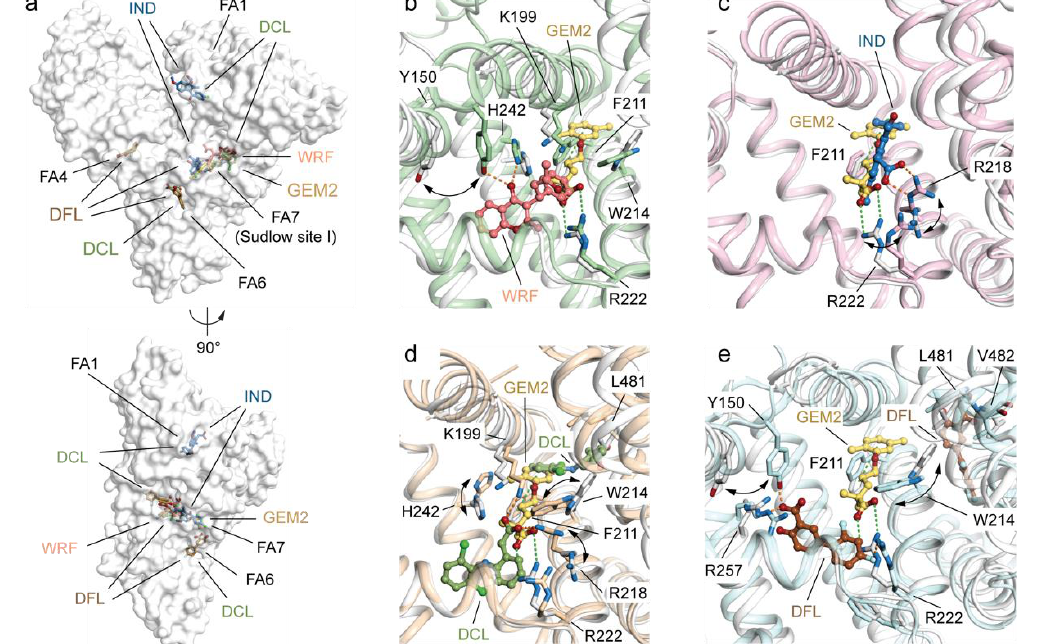
Figure 5. Structural comparison of the ligand binding mode of GEM2 with that of other known drugs binding HSA Sudlow’s site I (FA7) in sub-domain IIA. ( a ) Molecular surface representation of the overall HSA-GEM complex (white; PDB identification code: 7QFE) aligned with HSA-warfarin (WRF; PDB identification code: 2BXD), HSA-indomethacin (IND; PDB identification code: 2BXM), HSA-diclofenac (DCL; PDB identification code: 4Z69), and HSA-diflunisal (DFL; PDB identification code: 2BXE) complexes. The superimposed complexes are shown in two orientations (90 ◦ rotation). Detailed view of the superimposed GEM2 (yellow orange) to ( b ) WRF (salmon), ( c ) IND (sky blue), ( d ) DCL (smudge), ( e ) DFL (brown) molecules bound to Sudlow’s site II (FA4). The α -helices of HSA in complex with GEM2, WRF, IND, DCL, and DFL are represented by cartoon loops and coloured in white, pale green, light pink, wheat, and pale cyan, respectively. The selected labelled amino acid side chains are represented as sticks and coloured by atom type (carbon = white for the HSA-GEM2 complex, pale green for the HSA-WRF complex, light pink for the HSA-IND complex, wheat for the HSA-DCL complex, pale cyan for the HSA-DFL complex, firebrick for oxygen, and sky blue for nitrogen). Bound ligands are shown in a ball-and-stick representation and coloured by atom type (GEM2: carbon = yellow orange and oxygen = firebrick; WRF: carbon = salmon and oxygen = firebrick; IND: carbon = sky blue, oxygen = firebrick, and nitrogen = sky blue; DCL: carbon = smudge, oxygen = firebrick, nitrogen = sky blue, and chlorine = light green; and DFL: carbon = brown, oxygen = firebrick, and fluorine = pale cyan). For visualisation, only the side chains of amino acids of HSA forming inter-molecular polar interactions below 4.0 Å or presenting a notable difference are shown. Inter-molecular interactions are represented as dashed lines. Those established by GEM2 are coloured in light green while those formed by WRF, IND, DCL, and DFL are coloured in orange. The three-dimensional structure models were generated and rendered using Pymol